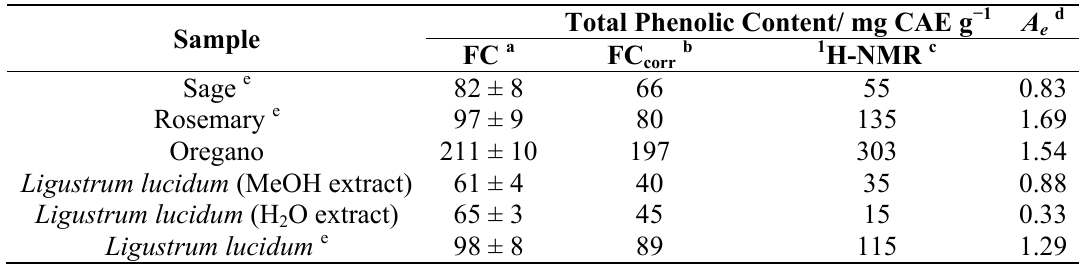
Table 7. Total phenolic content and A factor as determined for the plant extracts (caffeic e acid equivalence, CAE per gram of sample) by the use of the FC reagent method and the 1 H-NMR method [72].